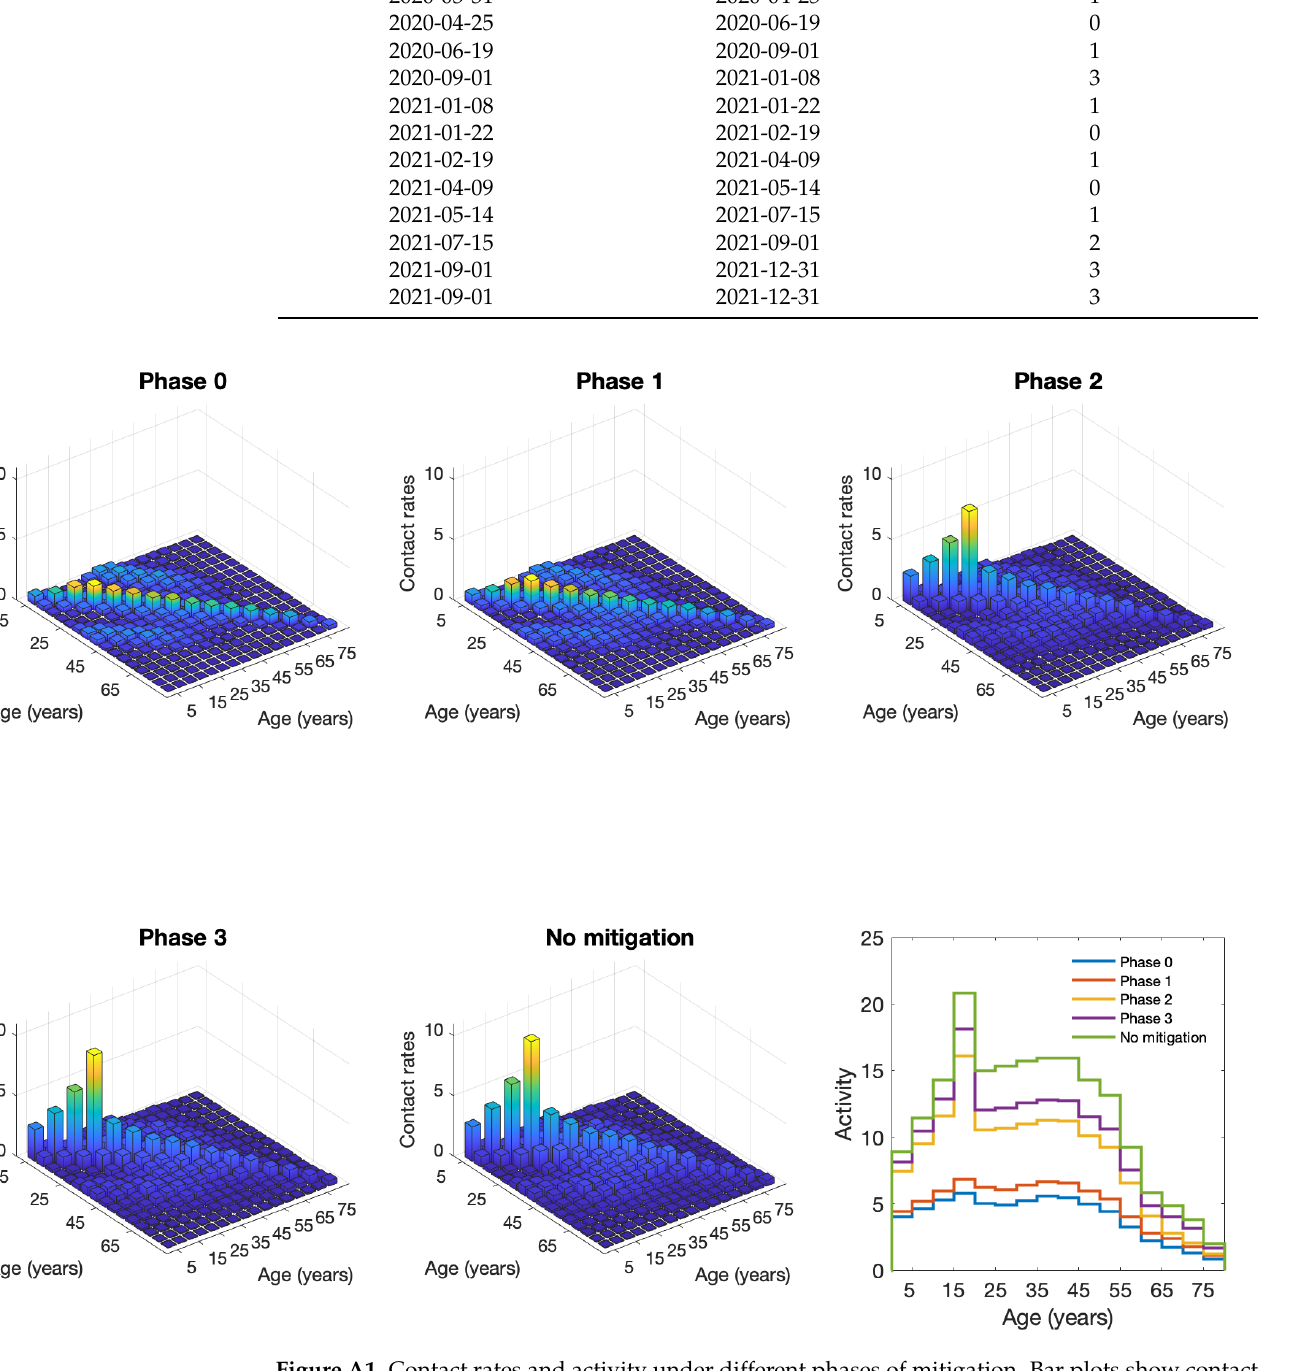
Figure A1. Contact rates and activity under different phases of mitigation. Bar plots show contact rates between age groups under different mitigation strategies, with compliance ( k ) assumed to be 100%. Taller bars, by subplot, have lighter colors. All bar plots have identical y-axis scale for comparison (but are not identical in colour scale). The total activity is shown in the line plot (bottom